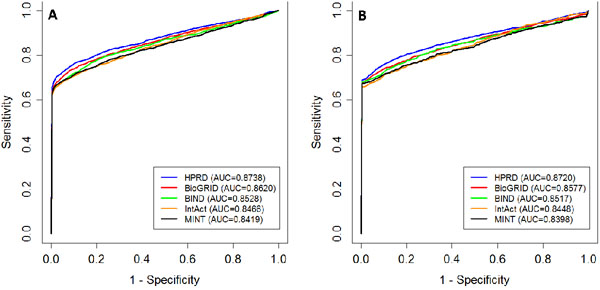
ROC curves of the five PPI networks on random controls (A) and linkage intervals (B). AUC scores for the validation of random controls are average of 10 independent runs.